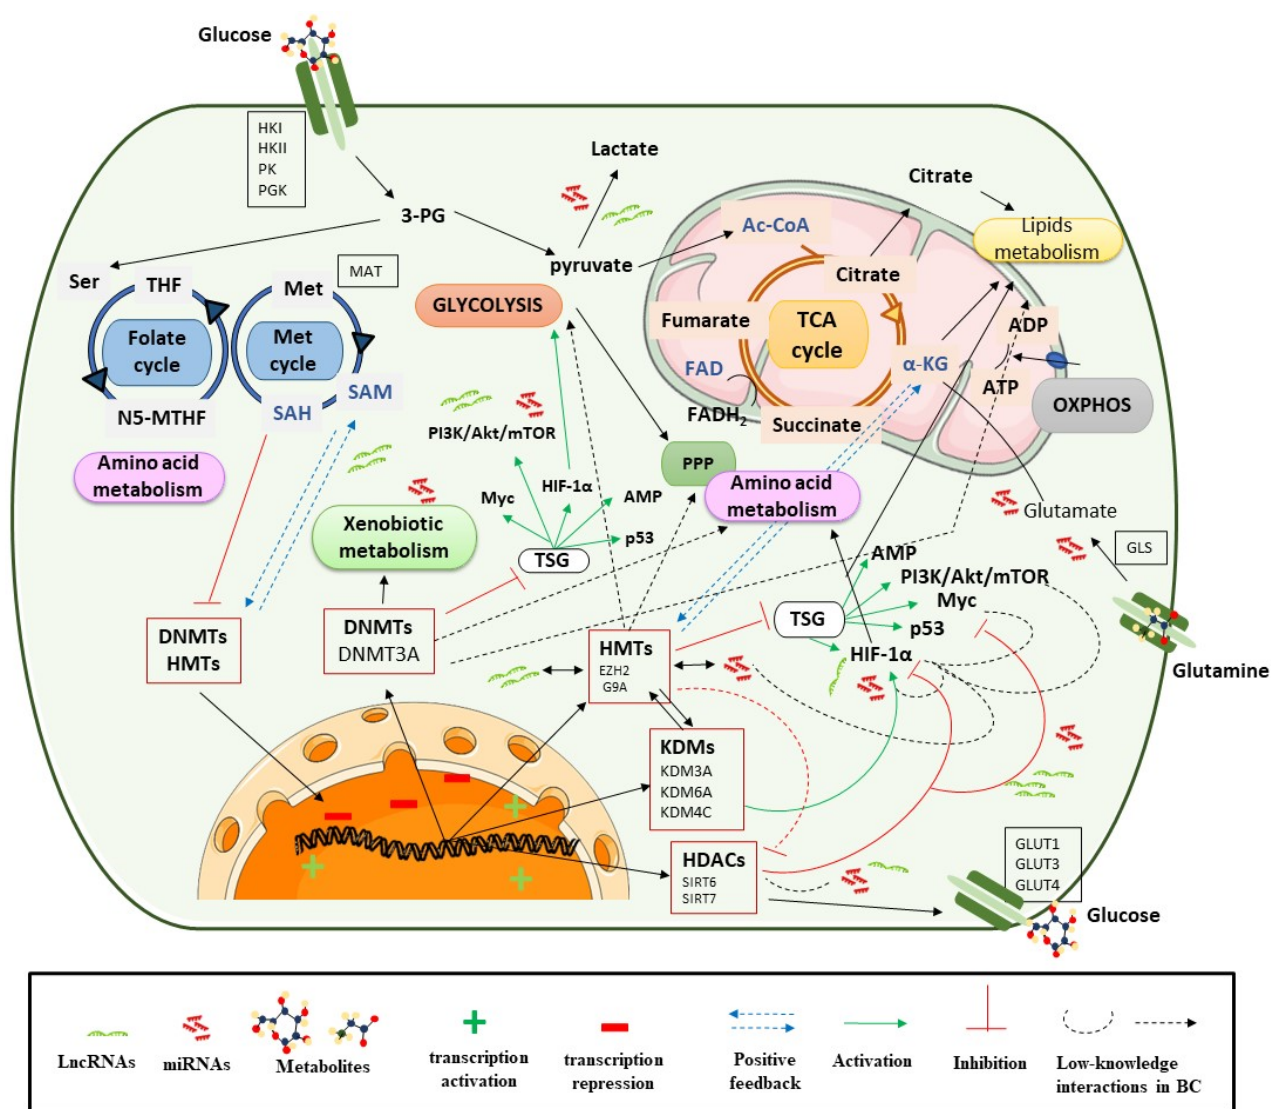
Figure 2. Epigenetic processes control metabolic pathways. Ac CoA: acetyl coenzyme A; ADP: adenosine diphosphate;